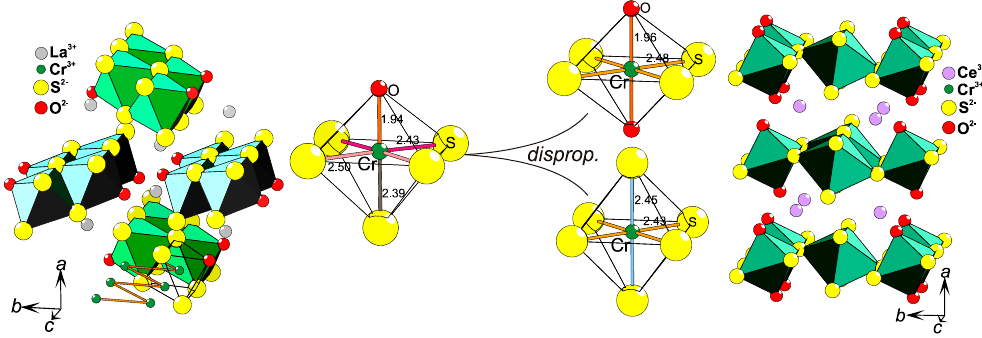
Figure 6. Parts of the RE CrS 2 O ( RE = La, Ce) [48,54] crystal structures are displayed ( left and right ). In LaCrS 2 O ( left ), the 1-D rows of [CrS 3/3 S 2/2 O 1/1 ] 3 edge-sharing octahedra are high-lighted, while the layers of edge- and vertex-sharing [CrS 4/3 O 2/1 ] 11/3 -[CrS 4/2 S 2/3 ] 7/3 octahedra in CeCrS 2 O are exhibited ( right ). In the center, the coordination disproportionation is shown as changes in local coordination of Cr, where all distances (in Å) are added.